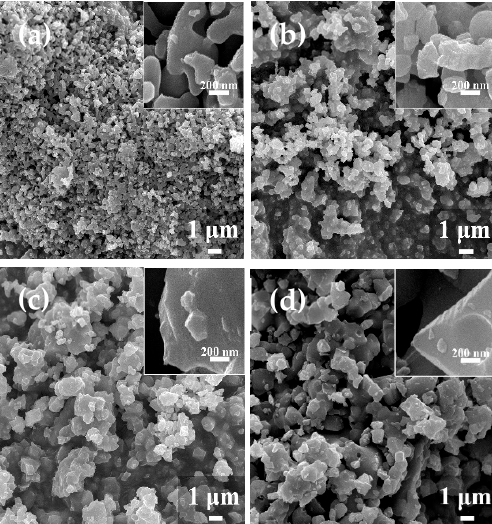
Figure 2. SEM images of β -TCP powders calcined at temperatures of ( a ) 800, ( b ) 900, ( c ) 1000, and ( d ) 1100 °C with insets of surface structure captured at higher magnification.